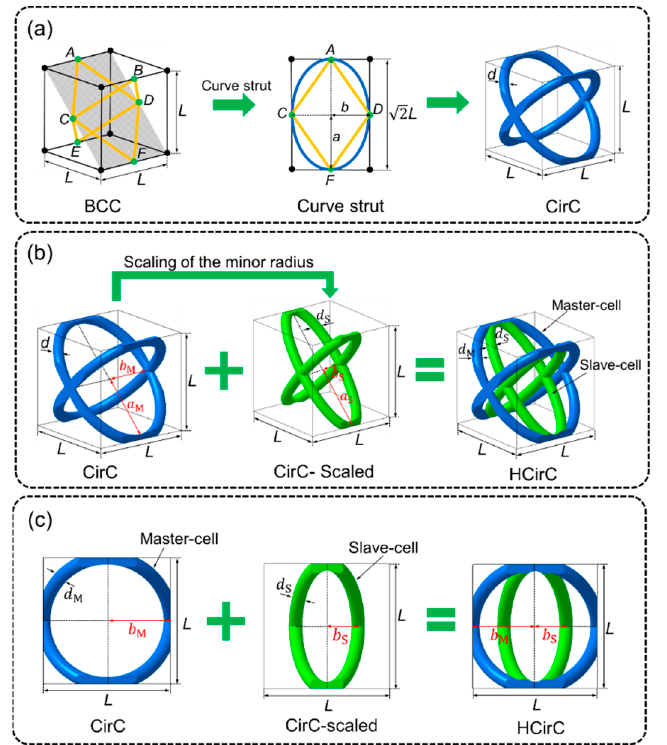
Figure 1. The basic design strategy for the hierarchical circular-cell lattice structure: ( a ) BCC and CirC; ( b ) HCirC; ( c ) front view of HCirC.